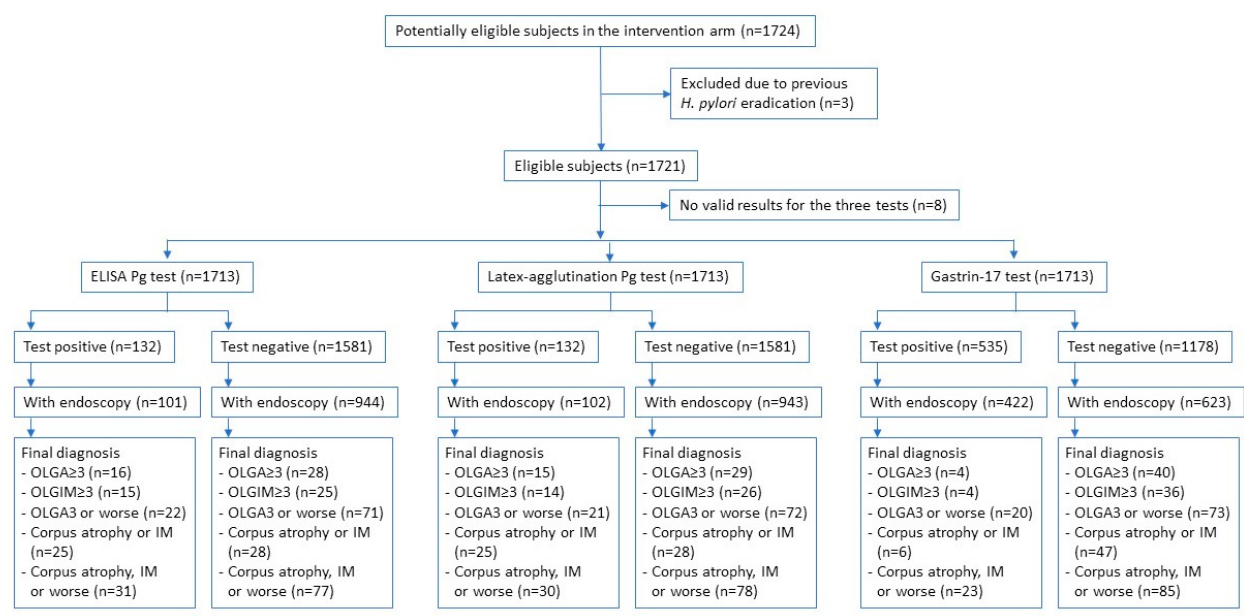
Figure 1. STARD Figure 1. STARD diagram.